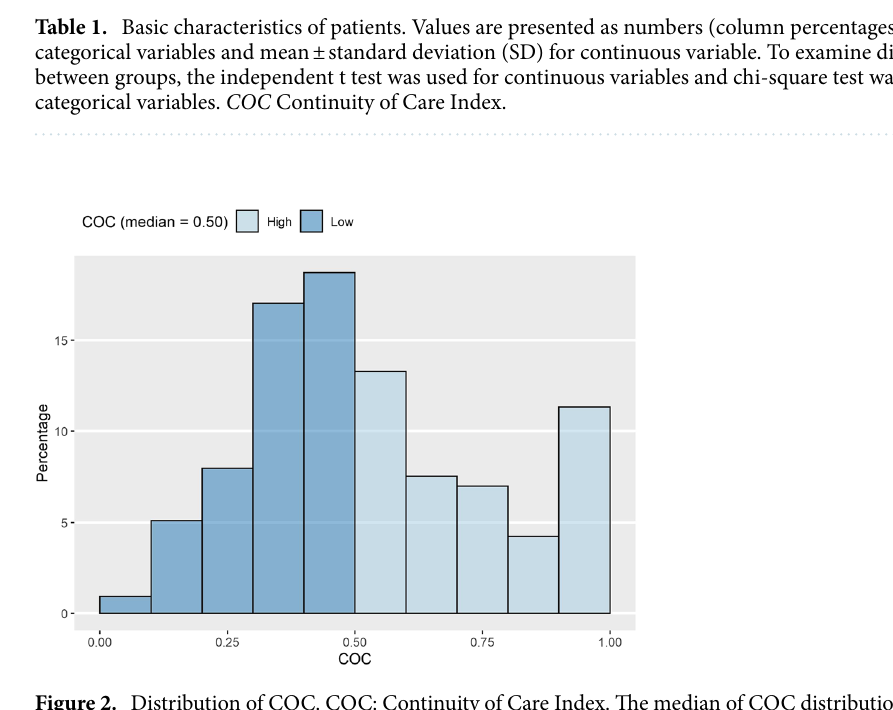
Figure 2. Distribution of COC. COC: Continuity of Care Index. The median of COC distribution was used for